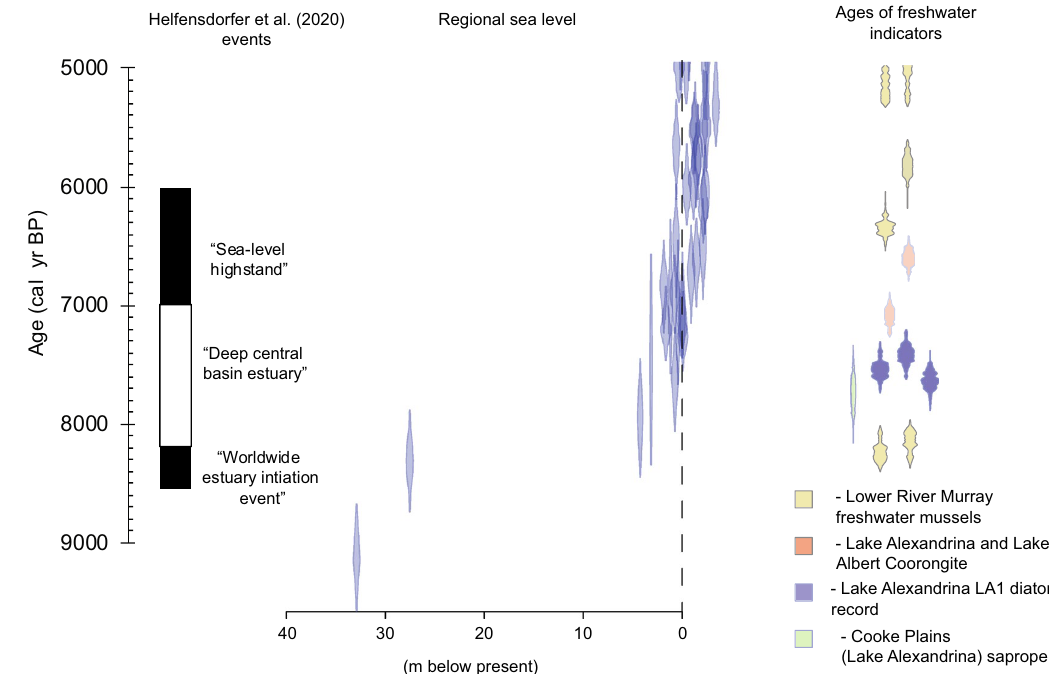
Figure 2. History of the lower River Murray inferred in 1,2 , South Australian high quality sea level data 11 , ages for freshwater mussels from the lower River Murray region and dates on a number of freshwater indicators from Lakes Alexandrina and Albert including Coorongite—a freshwater-derived sediment, dates for freshwater sapropel units and diatom record LA1 20 which is dominated by freshwater diatoms 20 . All ages in this plot were recalibrated for this study, with the marine ages (ref 11 ) calibrated with a ΔR of 84 years and a standard deviation of 59 years derived from the 3 most proximal sites in the CALIB marine reservoir correction data based (http:// calib. org/ marine/). Note that for the LA1 record we have assumed that the ages represent the time of deposition and did not gradually accumulate over the past c. 7000 years as suggested in the original